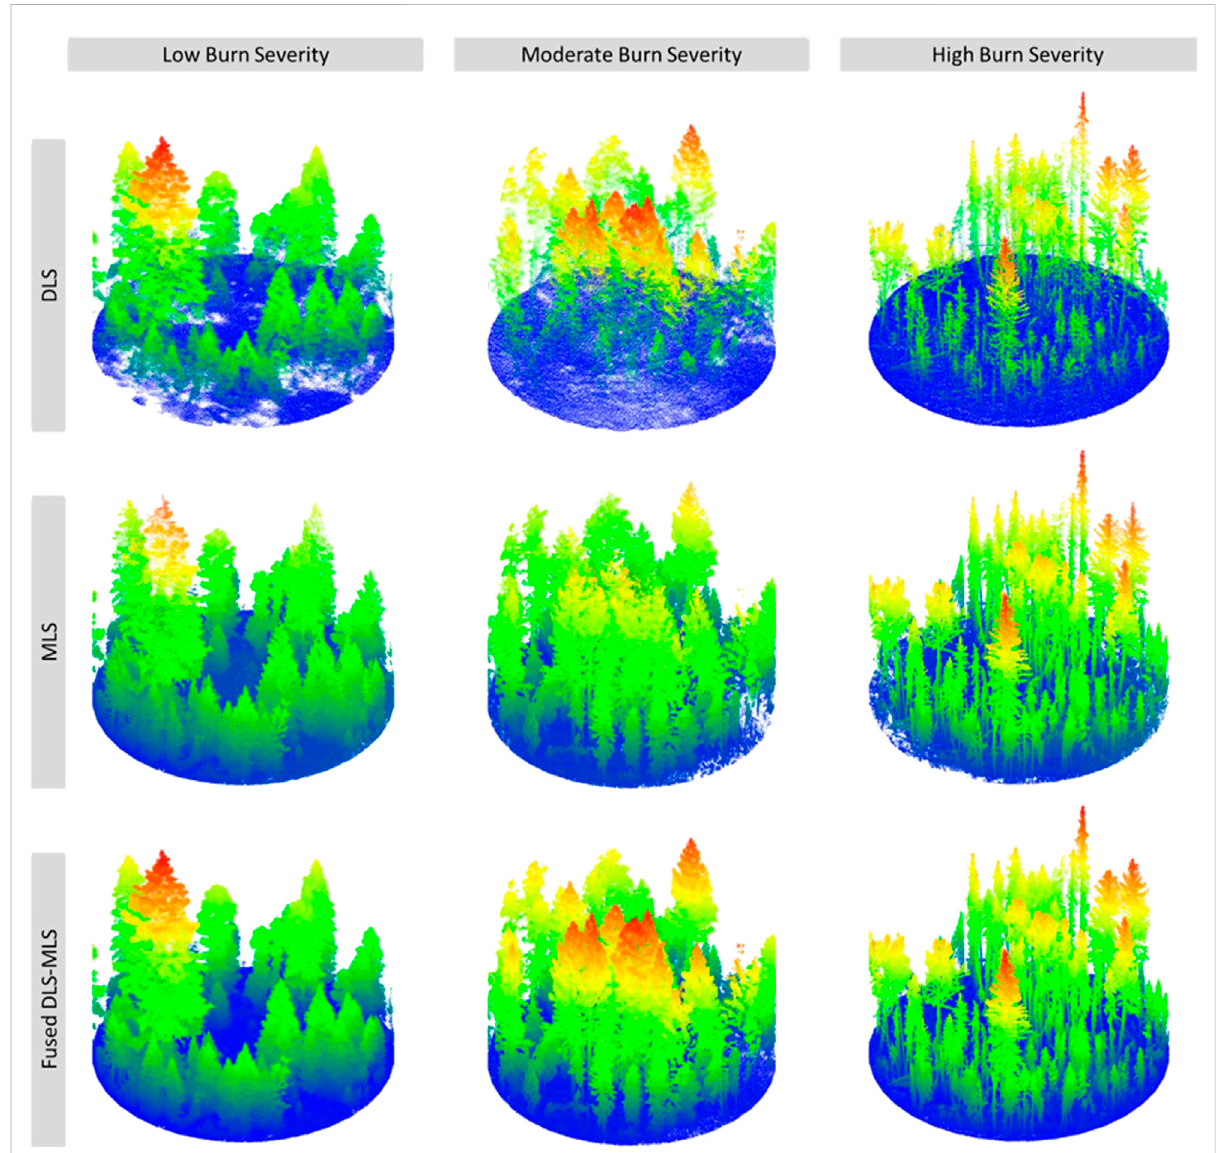
FIGURE 3 Examples of DLS, MLS, and fused DLS-MLS point clouds that are classi fi ed as different burn-severity